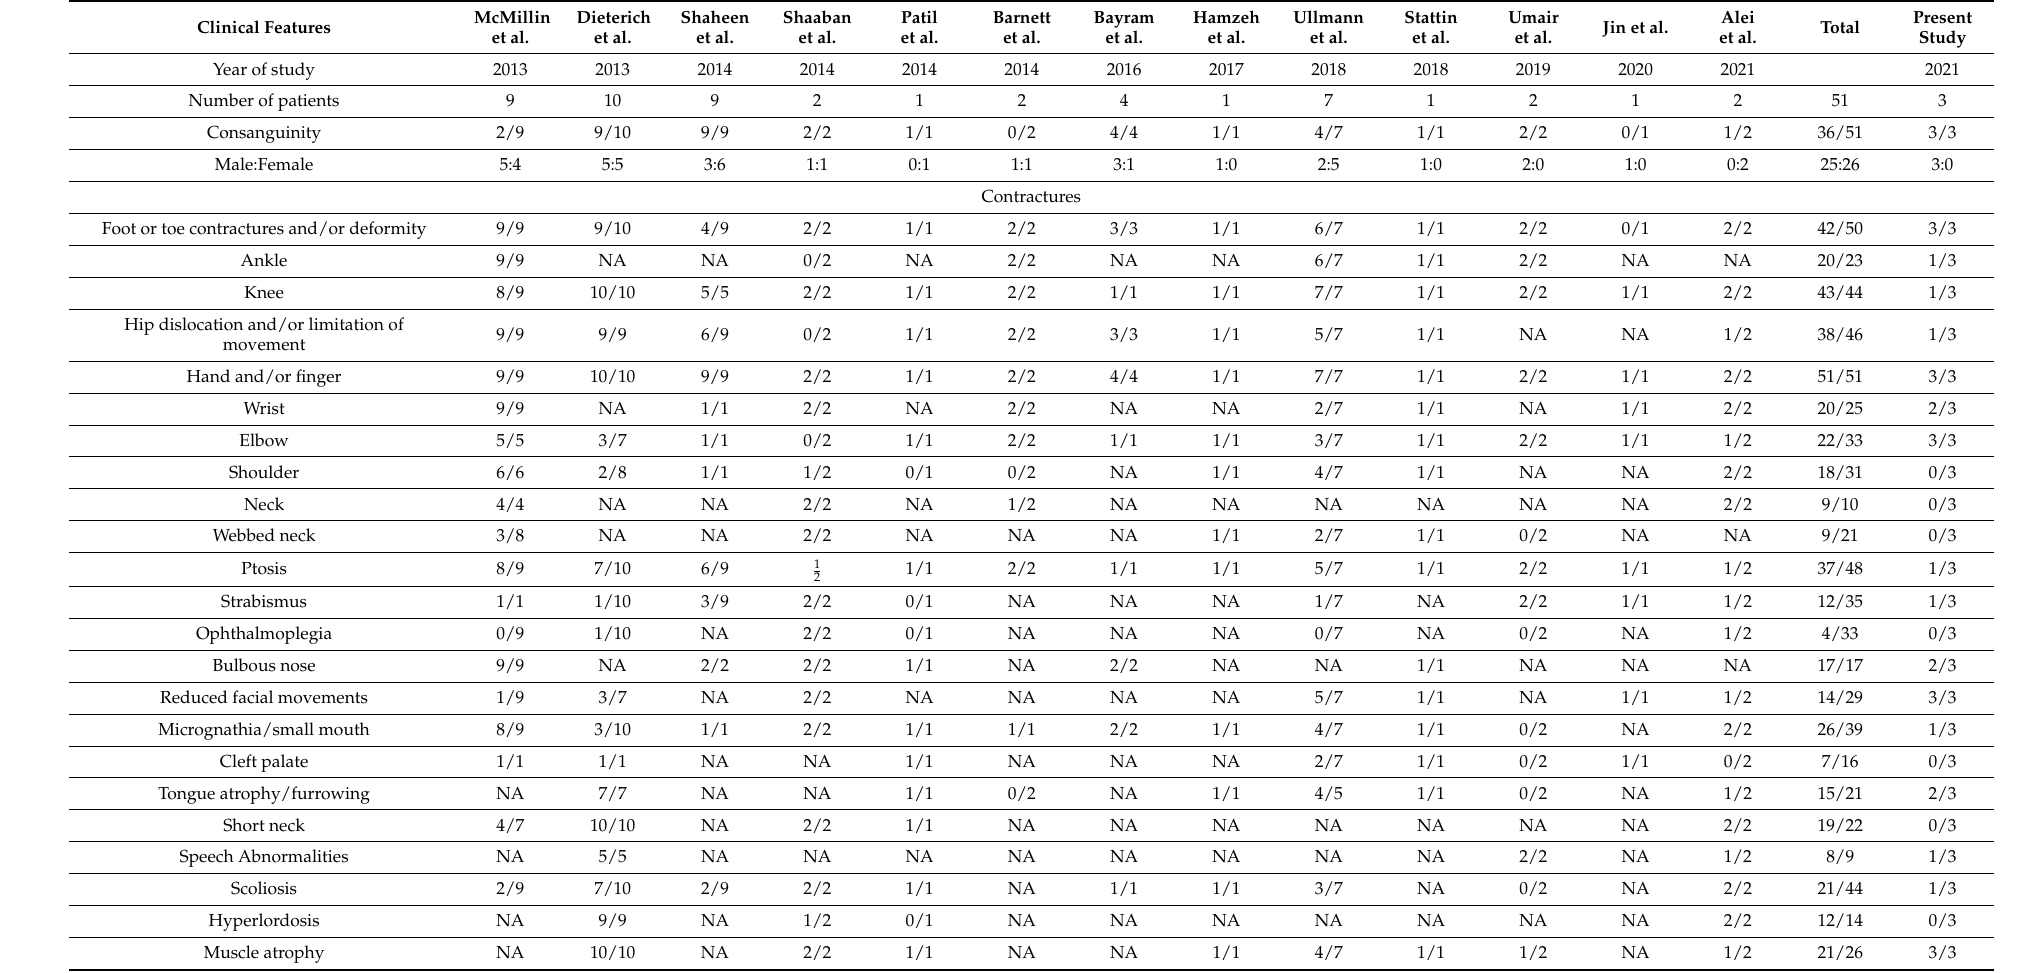
Table 2. Comparison of clinical features of this study with previous